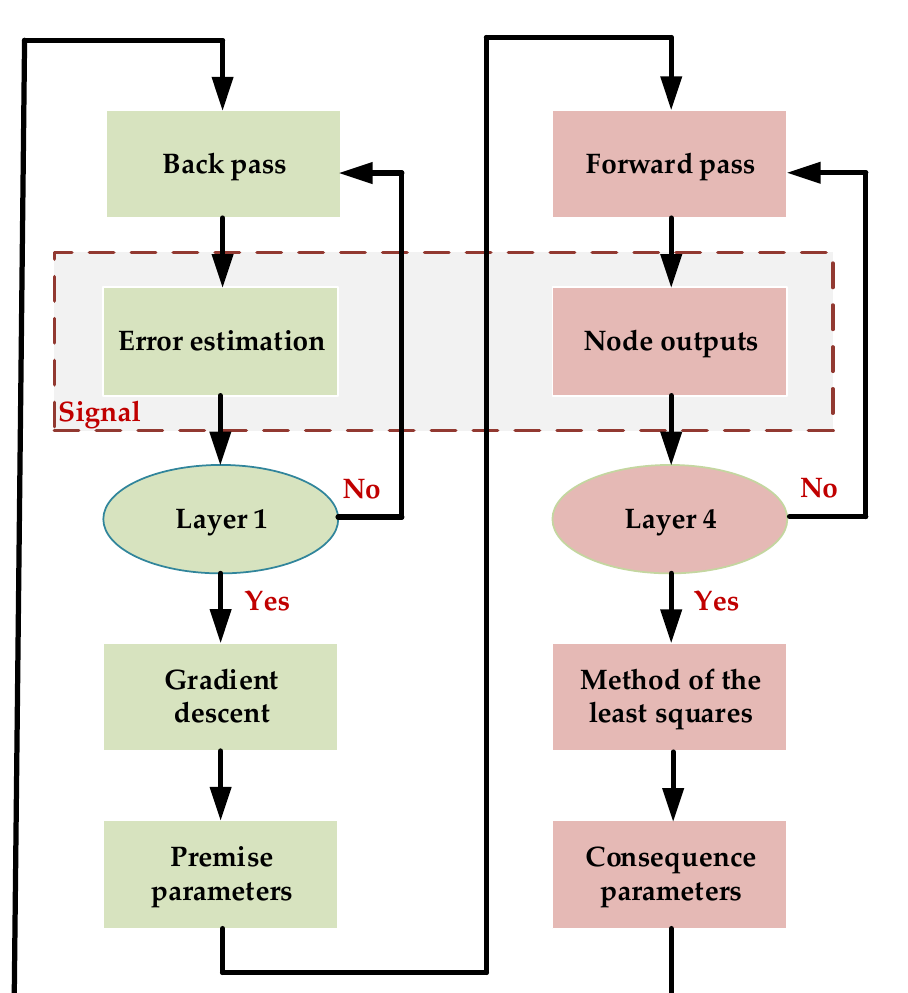
Figure 9. Hybrid algorithm of the ANFIS system training.